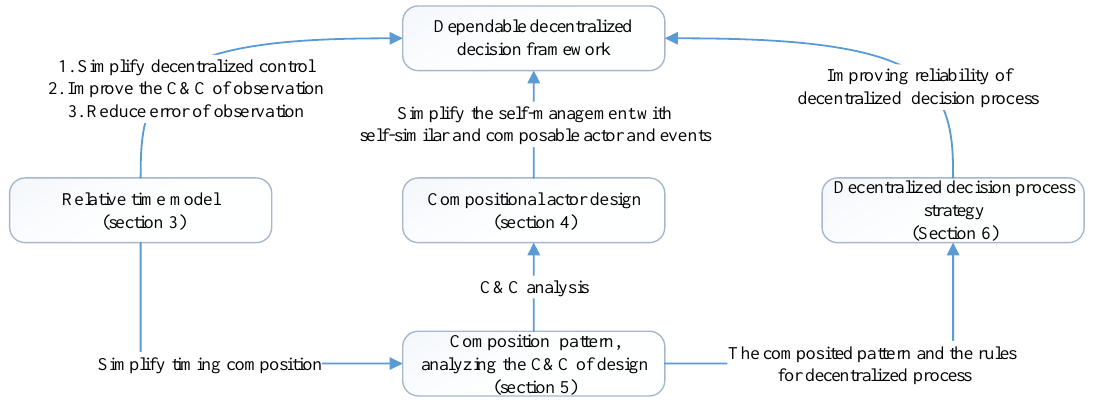
Figure 3. The relationship of the work.